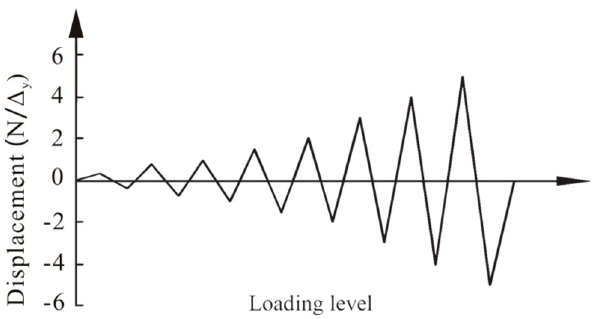
Figure 6. Loading history for the cyclic loading test.